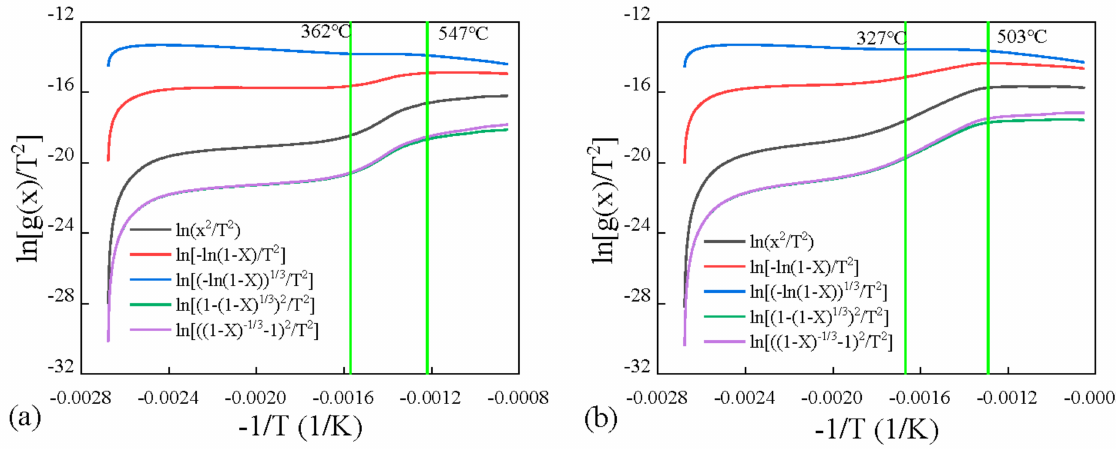
Figure 7. Kinetics obtained by applying Coats–Redfern method for ( a ) R-YL, ( b ) C-YL.